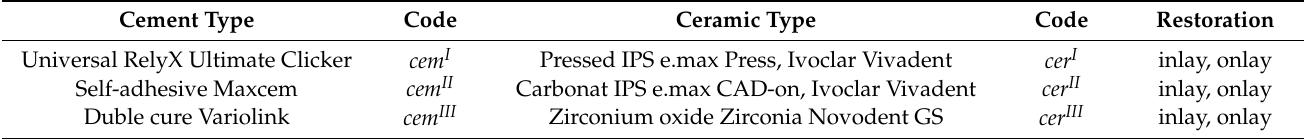
Table 1. Restoration type and associated commercially available materials.